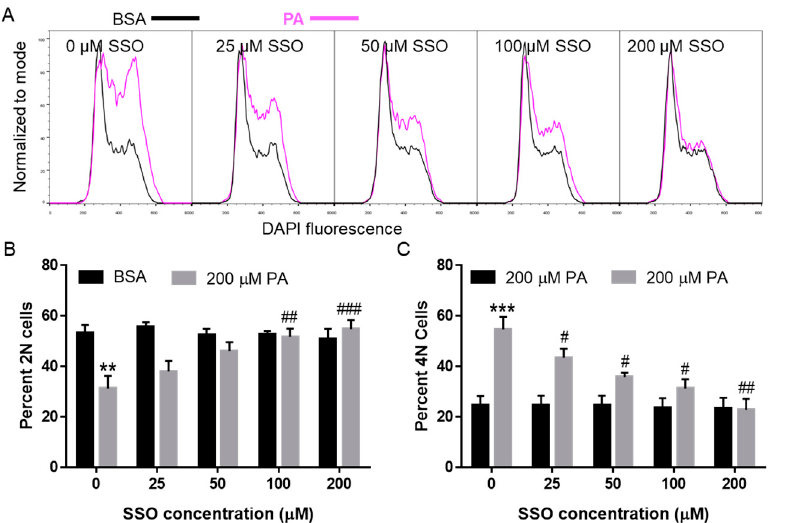
Figure 5. Cell cycle analysis of N2a cells following treatment with 200 µ M PA or BSA together with different concentrations of SSO. N2a cells were pre-treated with different concentrations of SSO for 1 h followed by incubation with 200 µ M PA or BSA for 6 h, their cell cycle profile was determined by DAPI via flow cytometry with representative histograms shown in ( A ), quantitated percent 2N cells shown in ( B ), and quantitated percent 4N cells shown in ( C ). Data presented (Mean ± SEM) were representative of three independent experiments. Data were analyzed using two-way ANOVA followed by Tukey’s multiple comparison test. ** p < 0.01 vs. BSA control; *** p < 0.001 vs. BSA control; # p < 0.05 vs. 200 µ M PA; ## p < 0.01 vs. 200 µ M PA; ### p < 0.001 vs. 200 µ M